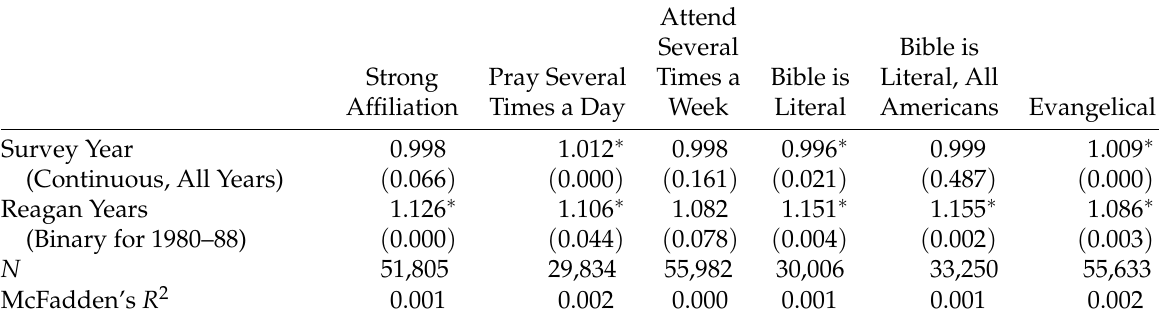
Table 1: Intense religion over time, accounting for exceptional Reagan years.